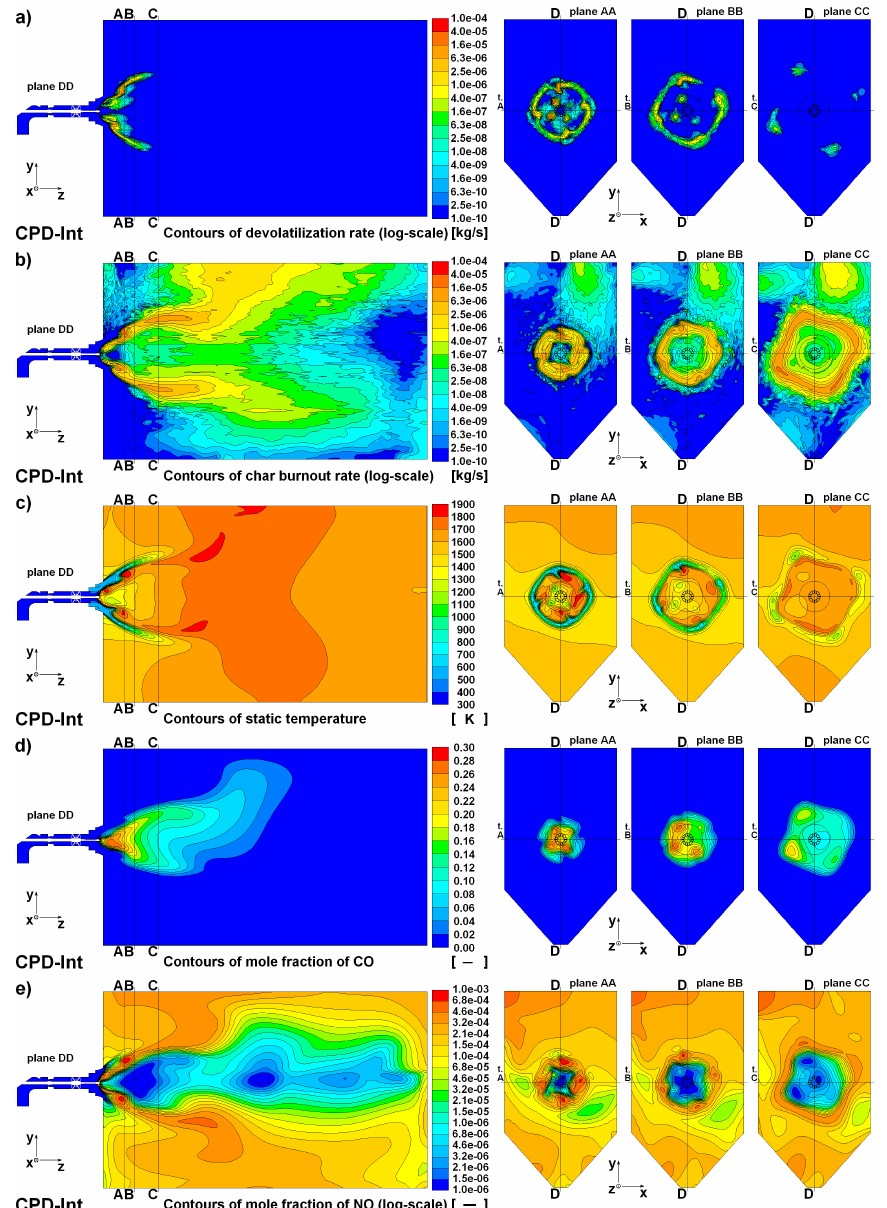
Figure 7. Results obtained by means of the CPD-Int model. ( a ) Devolatilization rate; ( b ) char burnout rate; ( c ) static temperature; ( d ) mole fraction of CO; and ( e ) mole fraction of